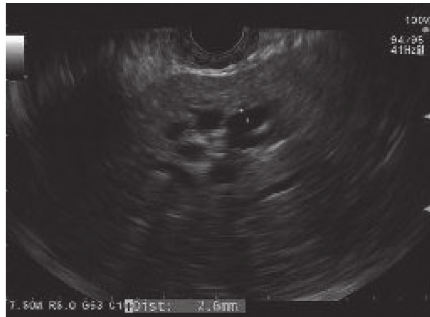
Figure 2: Endoscopic ultrasound showing a dilating segment 3 biliary radicle.